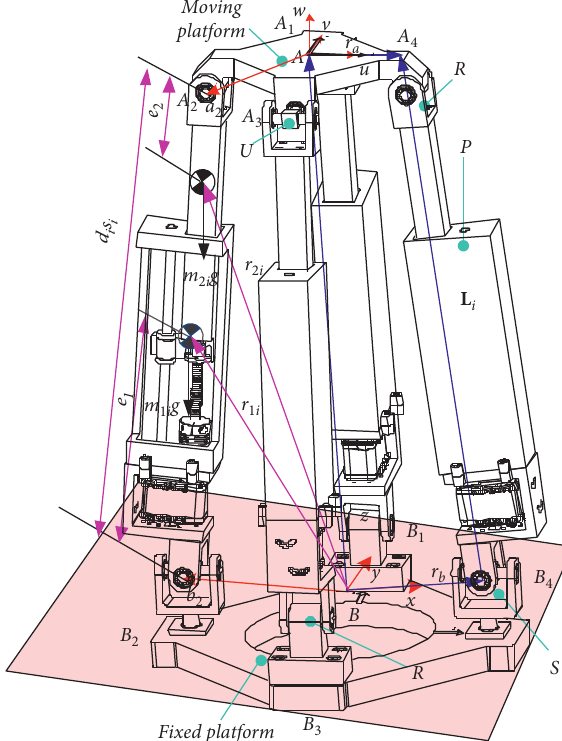
Figure 3: Structure diagram of parallel